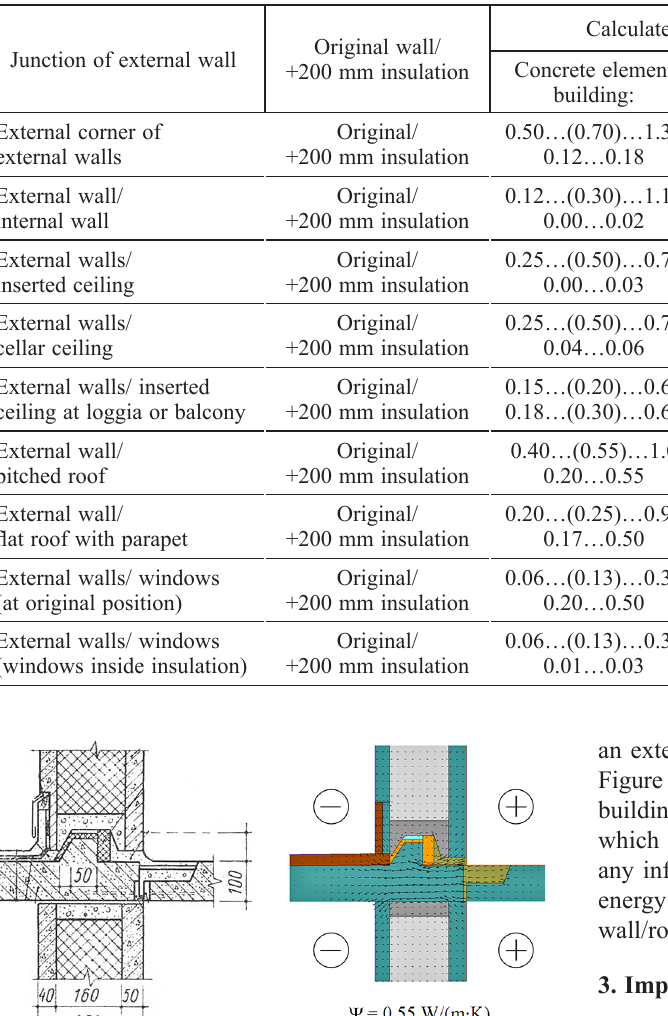
(right)Table 2. Calculated linear thermal transmittances Y oi , W/(m·K) of various external wall junctions for different building types by using overall internal dimensions of a building envelope. Upper row is for pre-renovation situation and lower row for post- renovation situation with +200 mm thermal insulation as an example. Values are given as a range, and at substantial variation, with a third value in between as the most probable (in